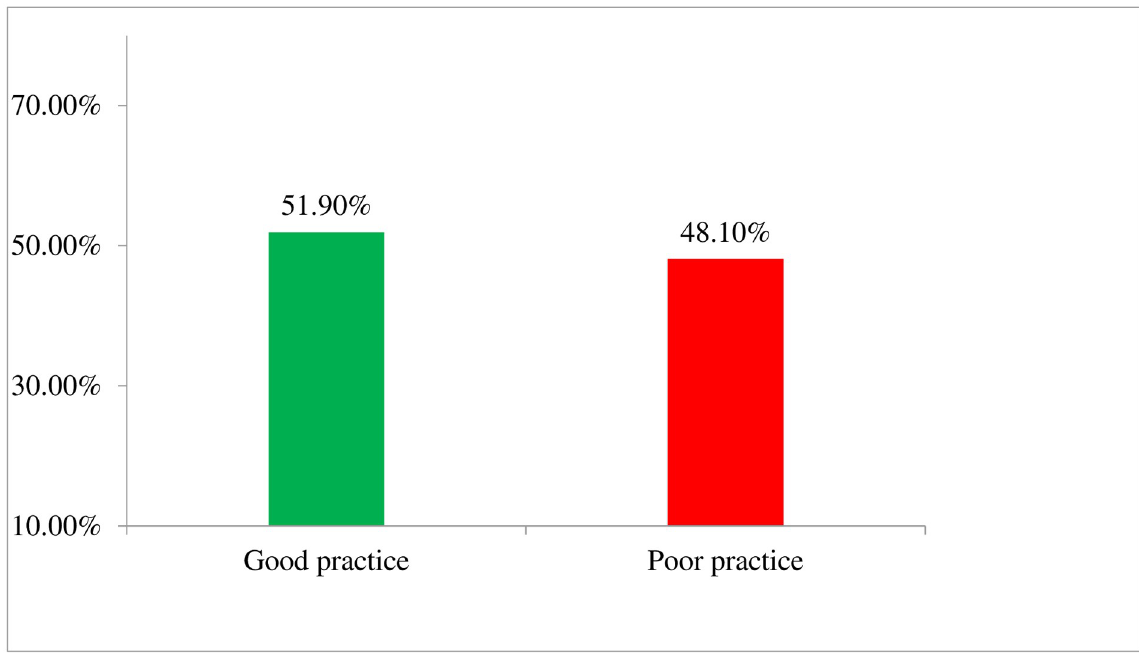
Fig 3. Pressure ulcer prevention practice level among nurses working in public hospitals of Harari regional state and Dire Dawa city administration, Eastern Ethiopia, 2018.